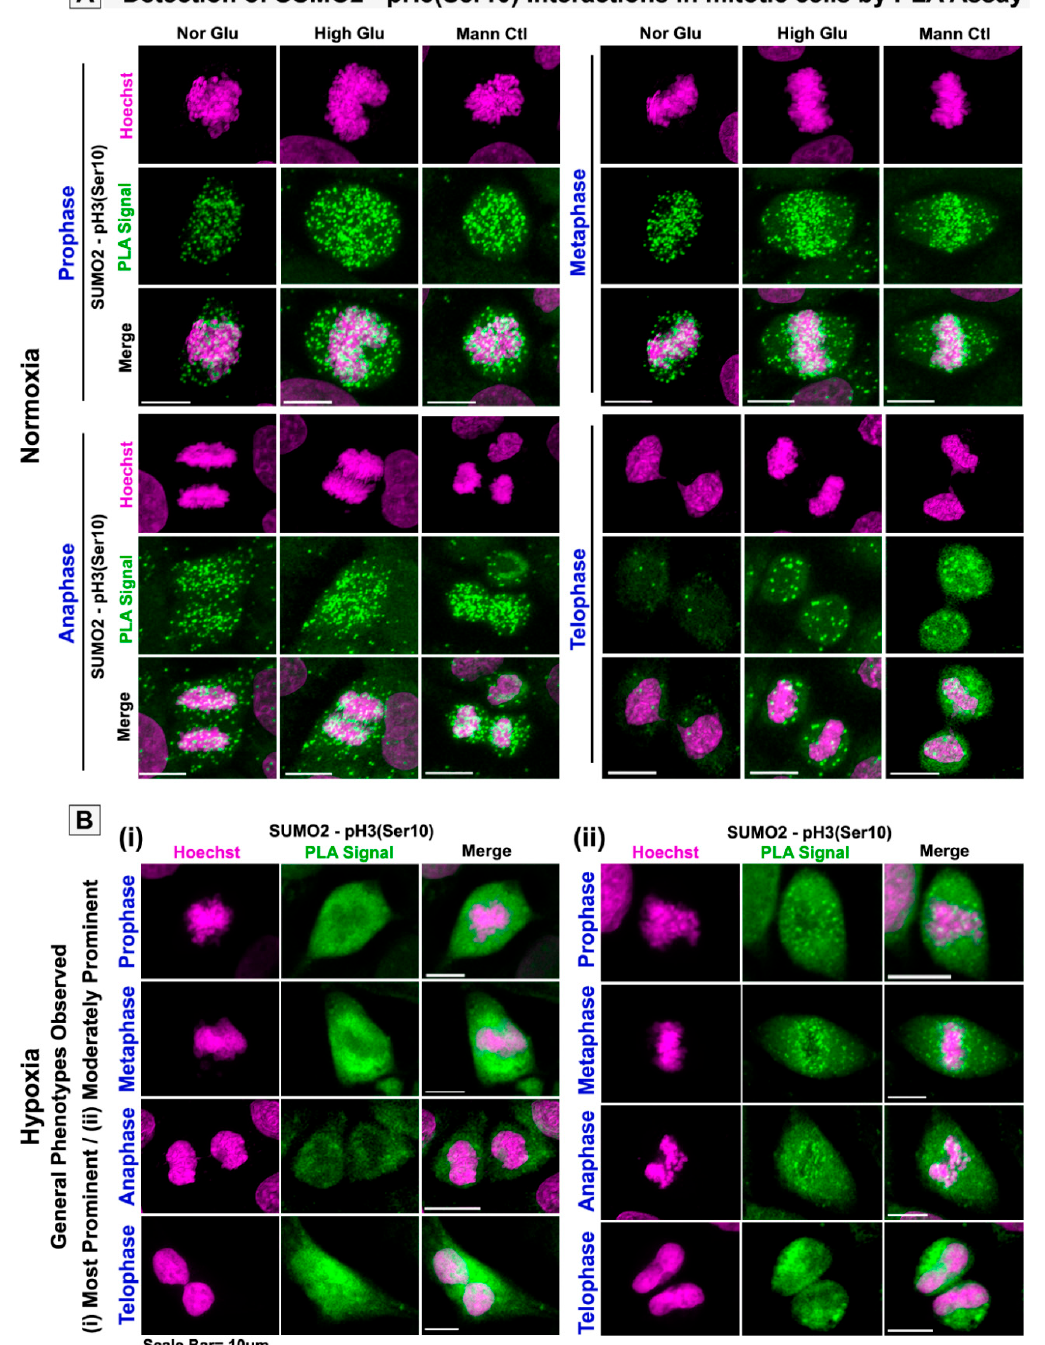
Figure 5. Proximity ligation assay shows that acute hypoxia triggers cytoplasmic sequestration of SUMO2-modified pH3(Ser10) in mitotic cells. CaSki cervical cancer cells were cultured in the general experimental set-up for 96 h. ( A ) Protein–protein interaction detection assay, the proximity ligation assay (PLA), showed enhanced localization of SUMO2-pH3(Ser10) PLA signal (green dots) in both HG and HG-HO conditions vs NG in normoxia. ( B ) On the contrary, the PLA signal was prominent in the cytoplasm and around the chromosome periphery in hypoxia-treated cells. Images shown in panel ( B ) ( i ) and ( ii ) represent observations across treatment conditions, irrespective of HG and HG-HO. See related Supplementary Figure S7 for correlated results in acute hypoxia-exposed non-mitotic tumour